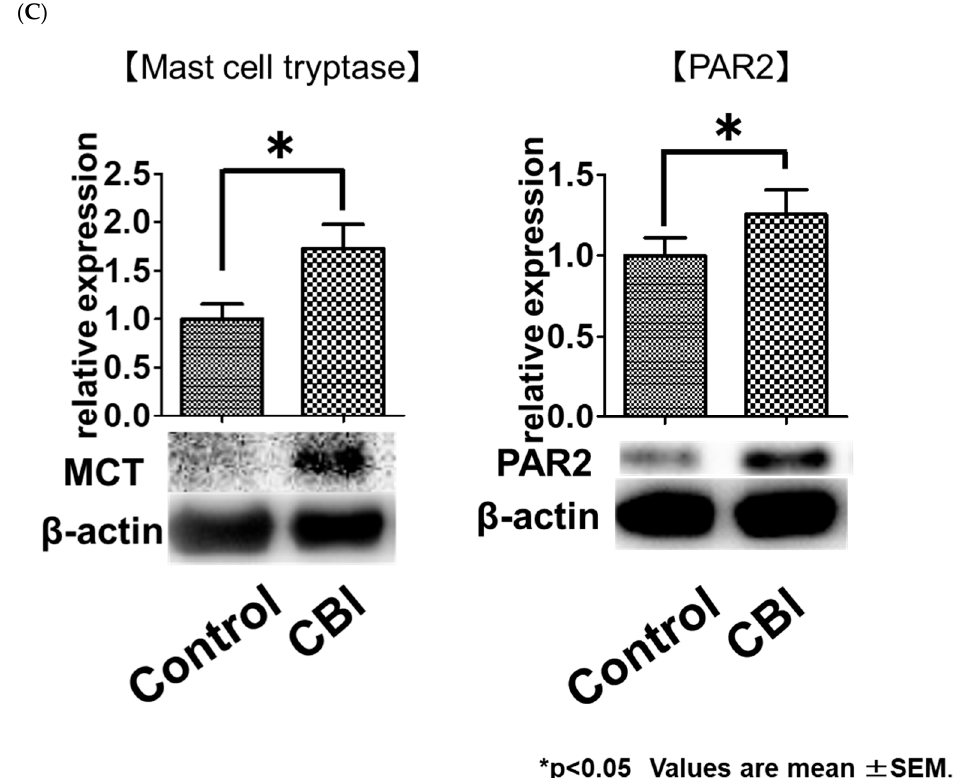
Figure 2. ( A ) Mast cell infiltration in the suburothelial layer of the bladders from the control and CBI groups as seen with methylene blue staining (200× magnification; scale bars 50 μ m). The arrows point to mast cells in the bladder suburothelial layer. Bar graphs show the numbers/area of mast cells in the control and CBI groups. * p < 0.05 (Mann–Whitney U Test). ( B ) Immunohistochemical examinations of PAR2 in the suburothelial layer of the bladder specimens from the control and CBI groups (400× magnification; scale bars 100 μ m). Bar graphs show the numbers/area of PAR2-positive cells in the control and CBI groups. Values represent mean ± SEM. * p < 0.05 (Mann–Whitney U Test). ( C ) Expressions of MCT and PAR2 at the protein level in the bladder as assessed using Western blotting. The bar represents the mean ± SEM of 6–9 determinations, each from a different bladder. * p < 0.05 (Mann–Whitney U Test).